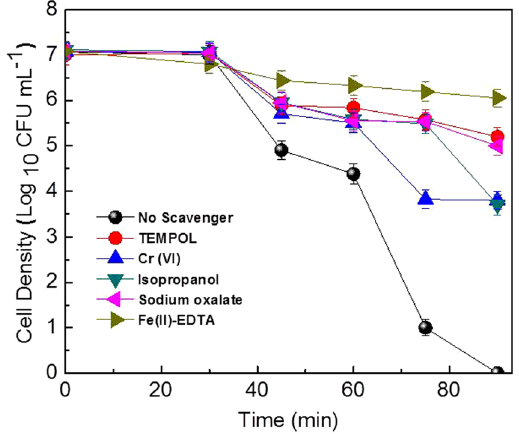
Figure 4. Effect of different scavengers on the solar-PCD of MDR E. coli in presence of Fe/ZnO NPs. Initial MDR E. coli concentration = 1.2 × 10 7 CFU/mL, Temperature = 35 ± 2 °C, pH = 6.5, [Fe/ZnO NPs] = 500 mg/L. Error bars indicate the standard deviation of replicates (n = 3).